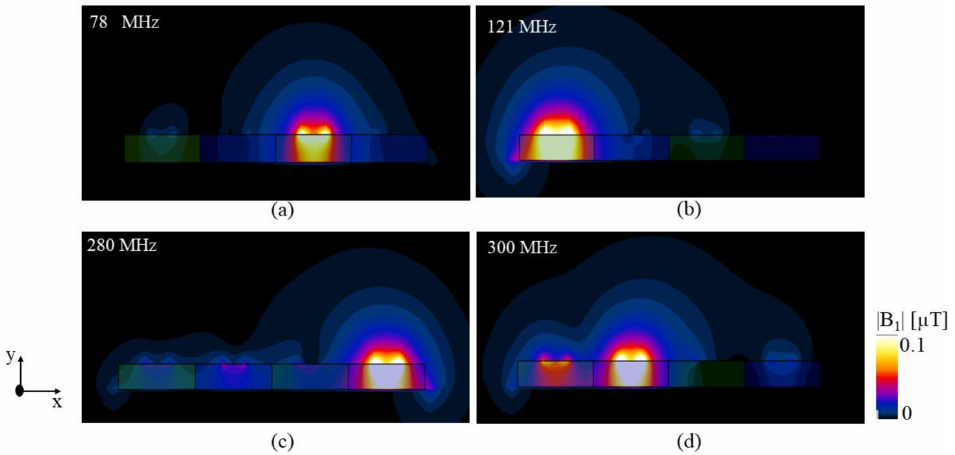
Figure 7. The x-y plane |B 1 | field and localization at each line for ( a ) 78, ( b ) 121, ( c ) 280, and ( d ) 300